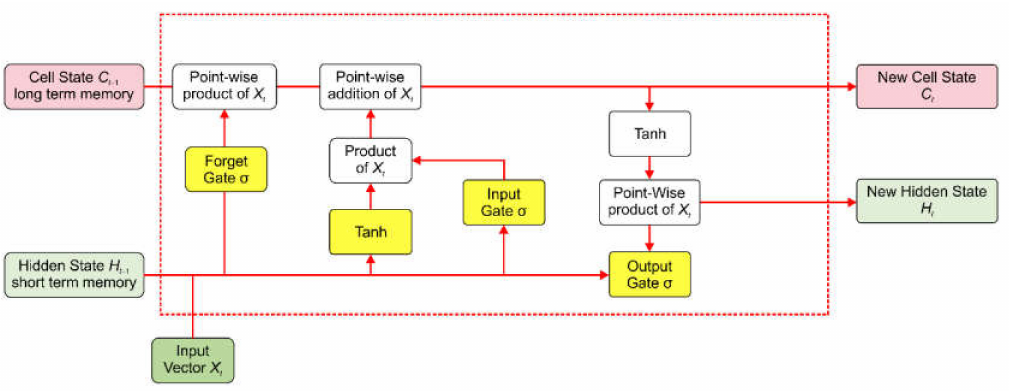
Figure 1. Architecture of LSTM